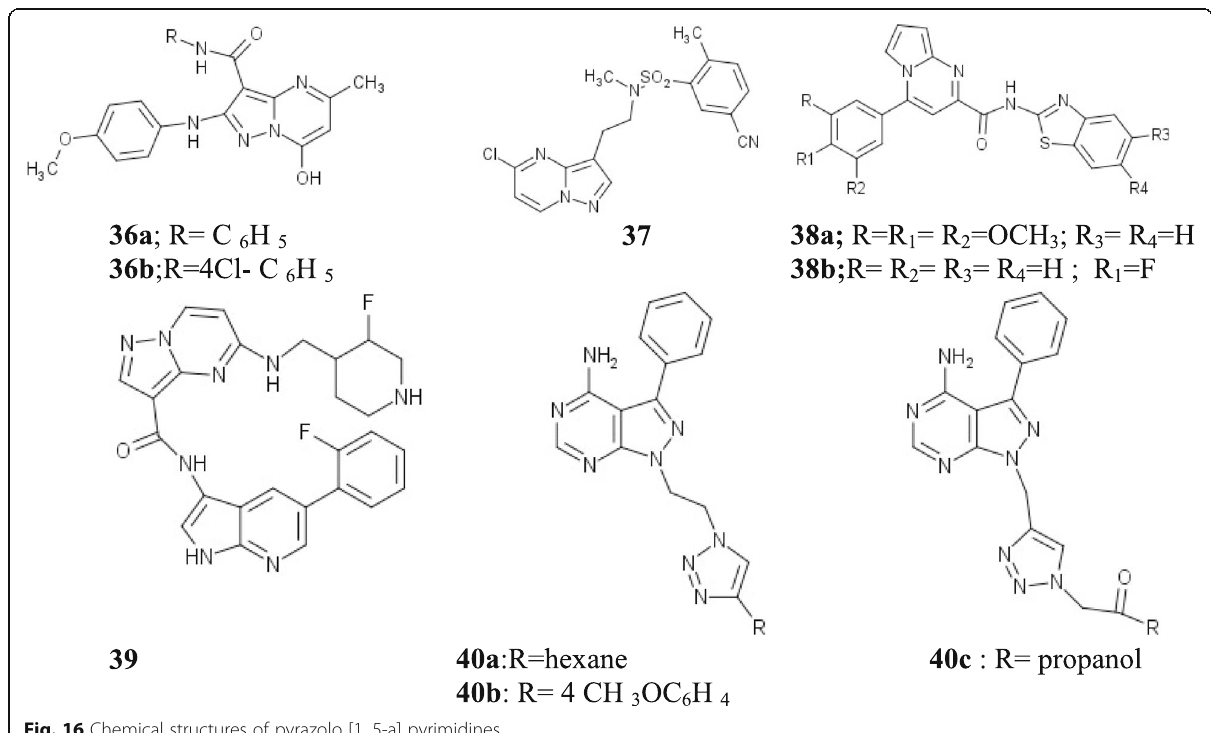
Fig. 16 Chemical structures of pyrazolo [1, 5-a]